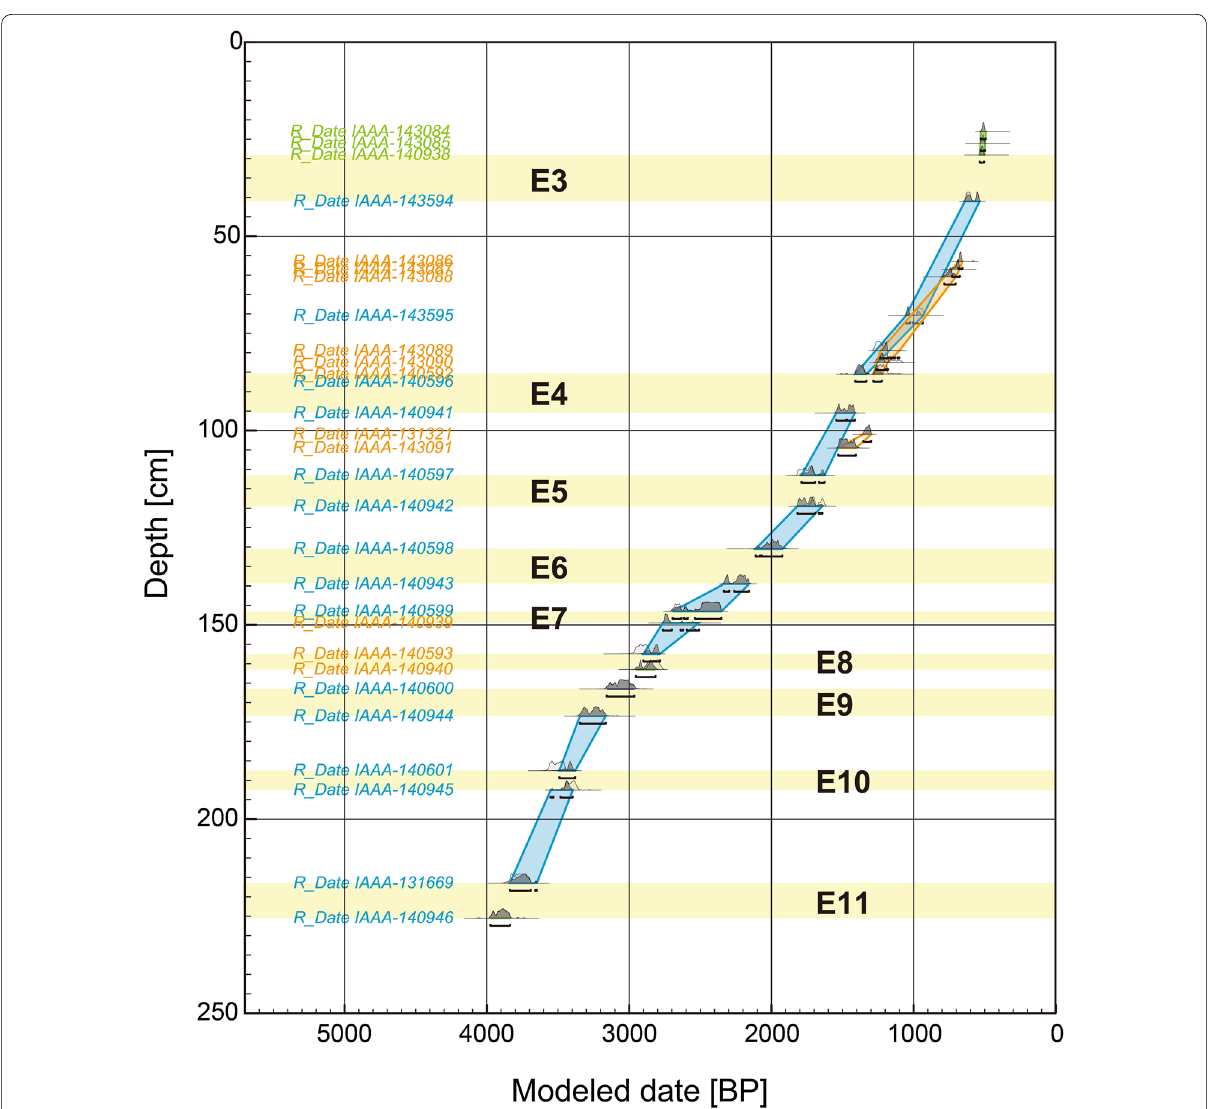
Fig. 4 Age–depth plots. Output results of the east ( orange ) and south ( green ) walls were shifted by match the output of the west wall ( blue ). The portion in light gray indicates the probability distributions for the single calibrated dates, whereas that in dark gray indicates the probability distributions for the modeled dates. Under bars below the probability distributions and depth model curves show the range of 95% probability distributions for the modeled